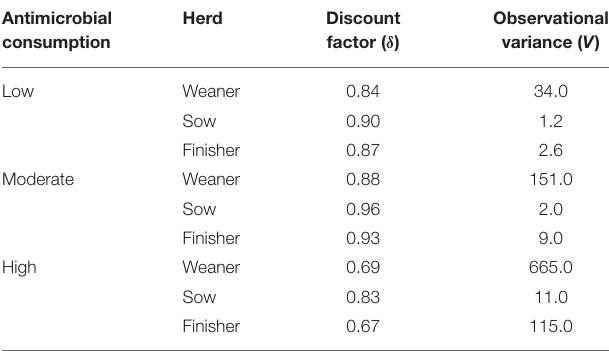
TABLE 3 | Values for the discount factor ( δ ) and observational variance (V) obtained from antimicrobial consumption data between 2008 and 2009 for weaner, sow, and finisher